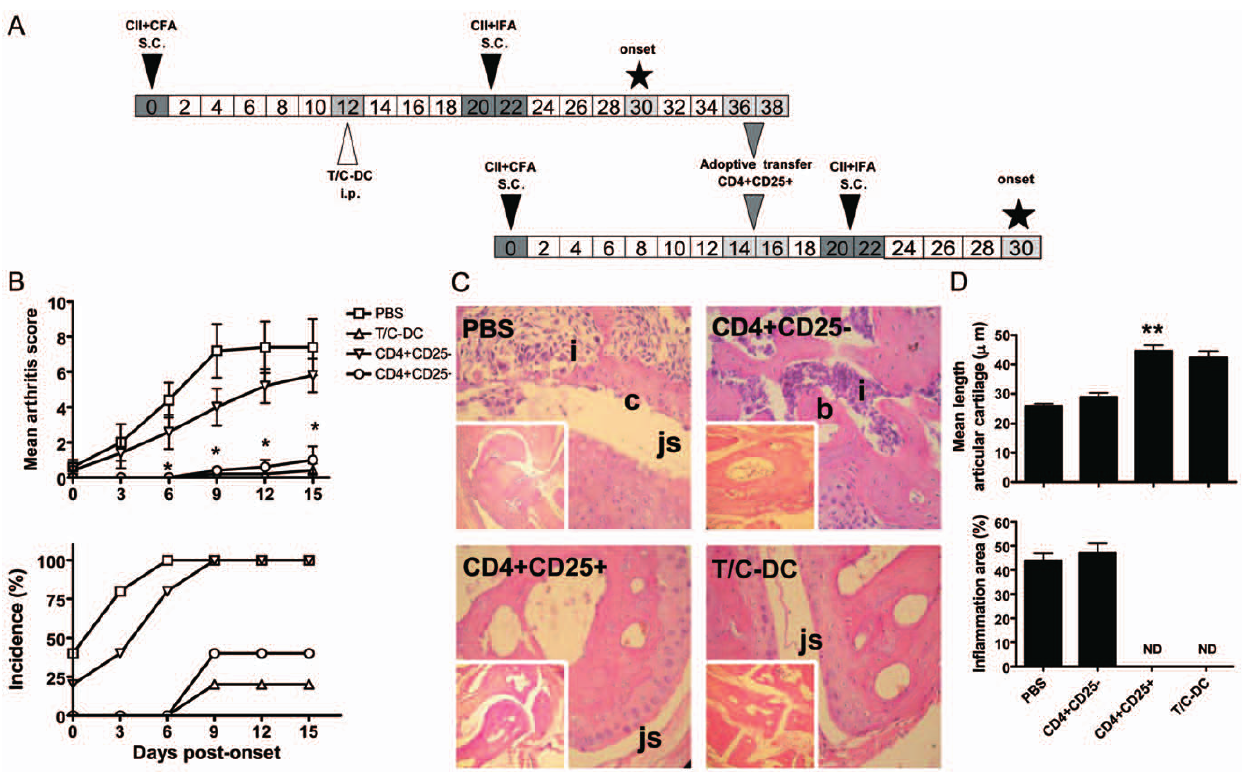
Figure 5. Decreased severity of CIA following adoptive transfer of CD4 + CD25 + T cells induced by the CII pulsed T/C-DC treatment. A) Scheme representing the experimental protocol followed to induce and transfer CD4 + CD25 + T cells, which is described in material and methods. B) Mice were injected with PBS, CII pulsed T/C-DC (5–8 6 10 5 /mouse), CD4 + CD25-, CD4 + CD25 + T cells, (3 6 10 5 /mouse), and the arthritis severity and incidence were assessed by clinical scoring during 15 days of onset. Values in arthritis score are the mean 6 SEM of 5 mice per group, * P , 0.05 for CD4 + CD25 + versus PBS on days 6, 9, 12 and 15. C) Histopathological examination of representative joints of PBS, CD4 + CD25 2 , CD4 + CD25 + T cells or CII pulsed T/C-DC recipient mice on day 15 of onset, original magnifications 10 6 (small squares) and 40 6 (big squares). The pictures show: inflammatory cell infiltrates (i), bone erosion (b), cartilage erosion (c), joint space (js). D) Graphs representing the measurement of the mean length of the articular cartilage and inflammation area from 5 points in each sample. Values are the mean 6 SD of 5 mice per group. ** P , 0.005 versus PBS on day 15 of onset.